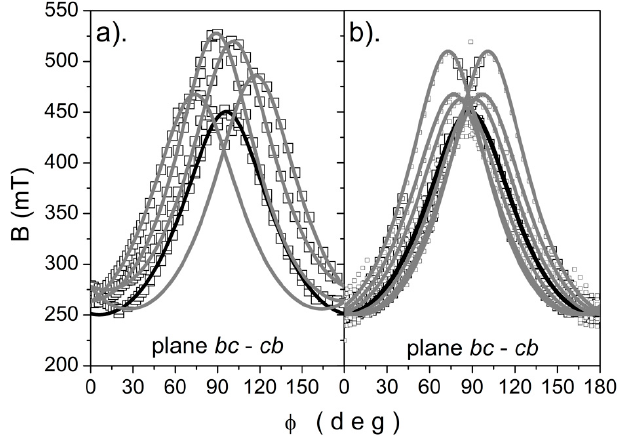
Figure 8. Comparison of angular dependencies for BaWO 4 : 0.5 at. % Ce ( a ) and BaWO 4 : 1 at. % Ce, 2 at. % Na ( b ) single crystals.